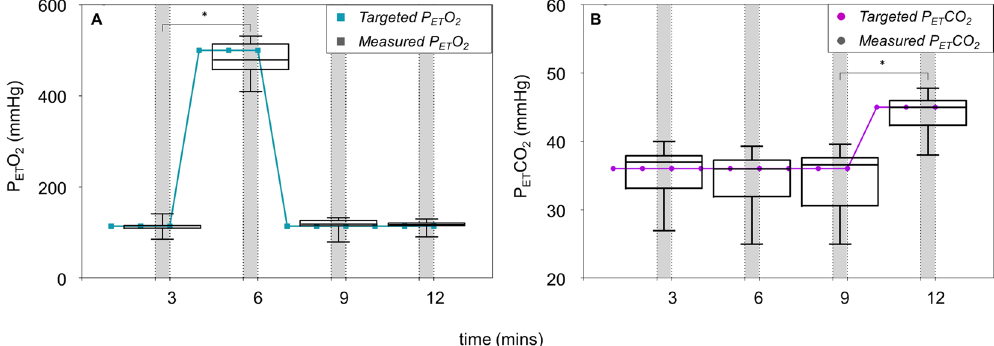
Figure 5. Changes in end-tidal partial pressure of oxygen (P ET O 2 ) and carbon dioxide (P ET CO 2 ) during the gas breathing sequence. ( A ) Target P ET O 2 (green line) and measured P ET O 2 (black box and whisker plots), along with ( B ) target P ET CO 2 (purple line) and measured P ET CO 2 (black box and whisker plots) from all 3 participants across the 12-minute imaging sequence. Whiskers show minimum and maximum data, and boxes show median and interquartile range. Breathing conditions were as follows: baseline (0–3 mins), isocapnic hyperoxia (3–6 mins), return to baseline (6–9 mins), and isoxic hypercapnia (9–12 mins). A period of 30 secs (grey bars) was allowed for image acquisition during each breathing condition.